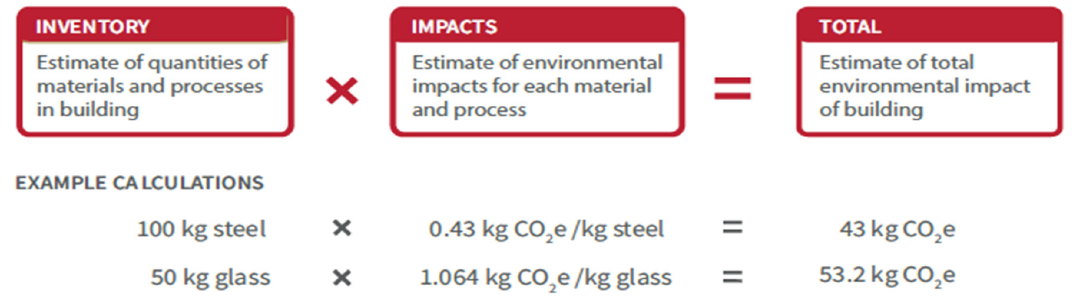
Figure 3. Illustration of the elements of a Life Cycle Impact Assessment (LCIA) [50].